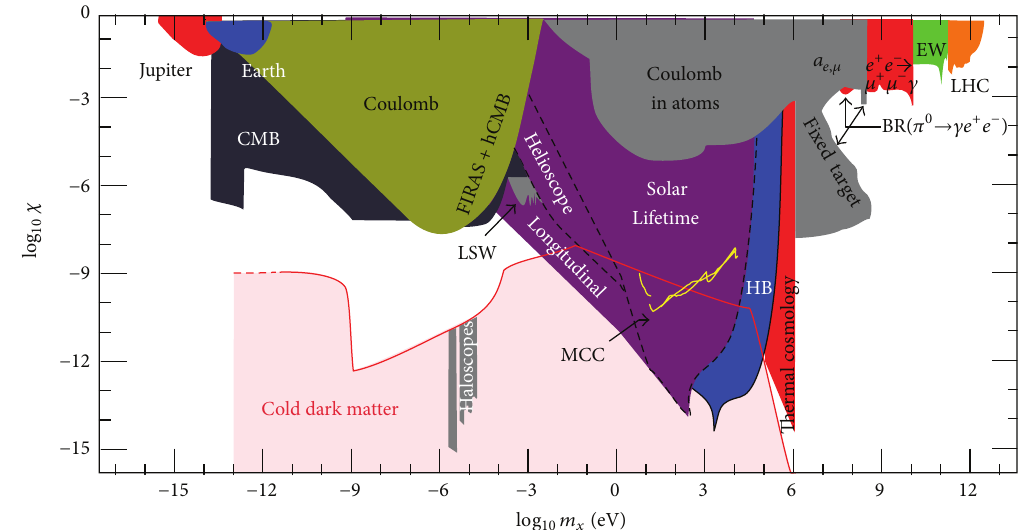
Figure 9: Constrained and still testable regions of photon/hidden photon